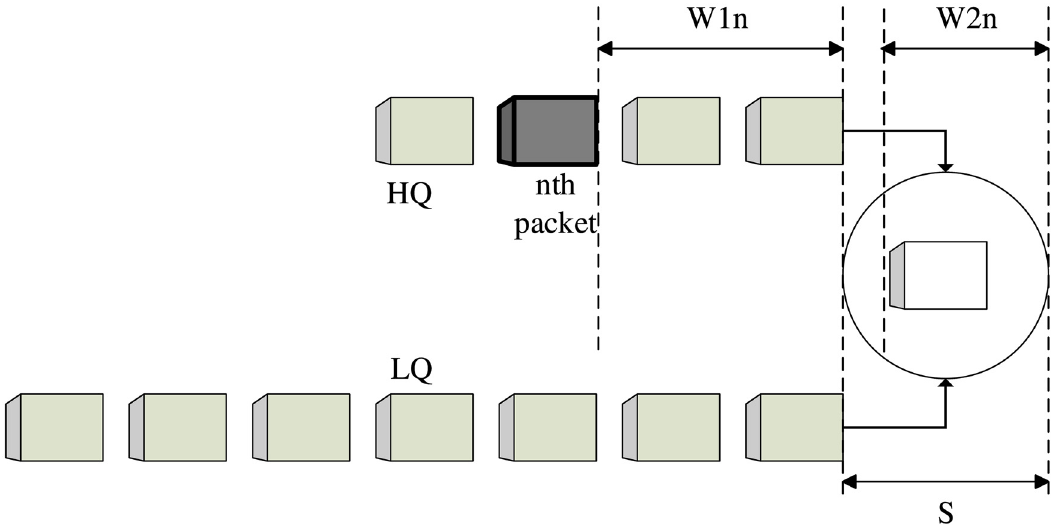
Fig 3. Virtual queues for